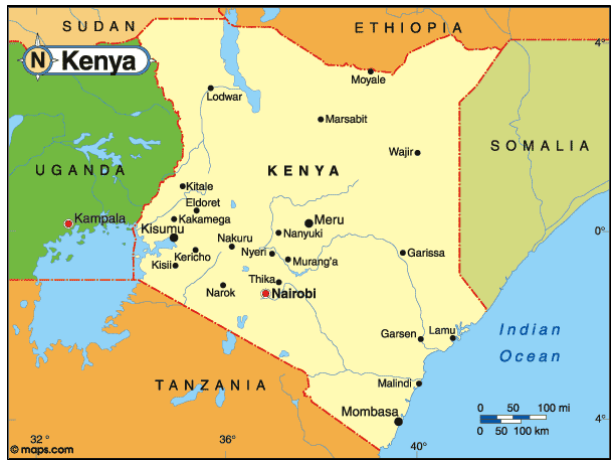
Figure 1 : Kisii Town location in Kenya, Source – Writterstake